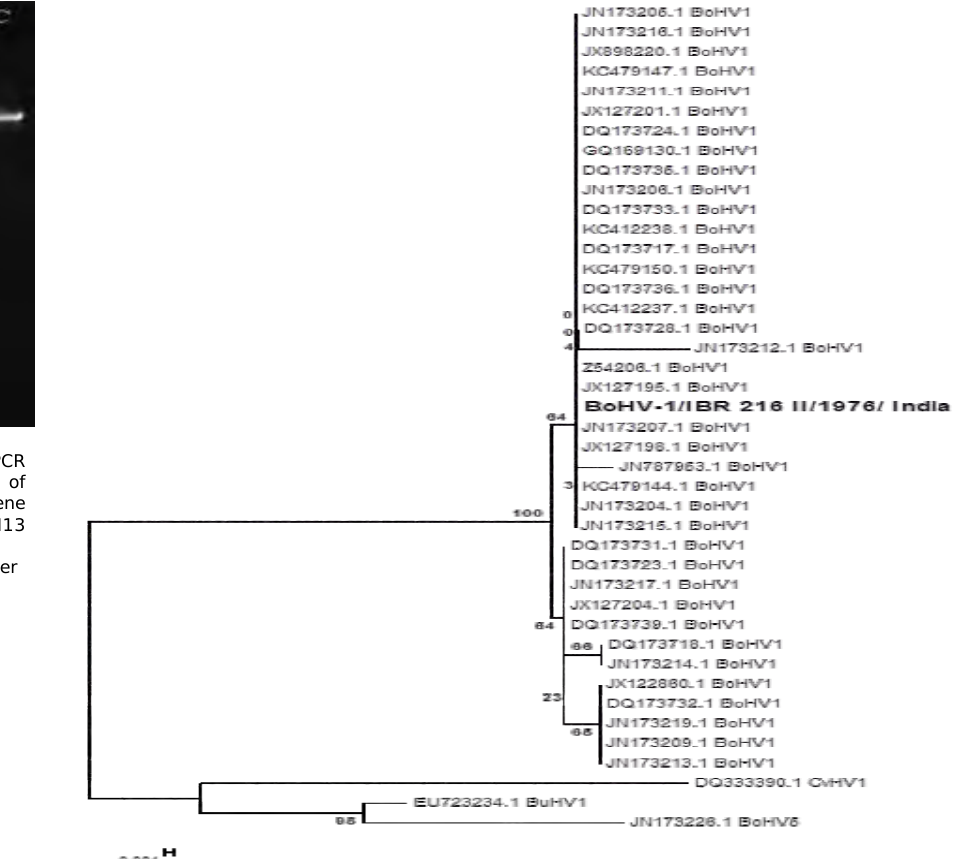
Figure-2. Phylogenetic analysis of glycoprotein C gene of various isolates of BoHV1 with other related members of Alphaherpesvirinae